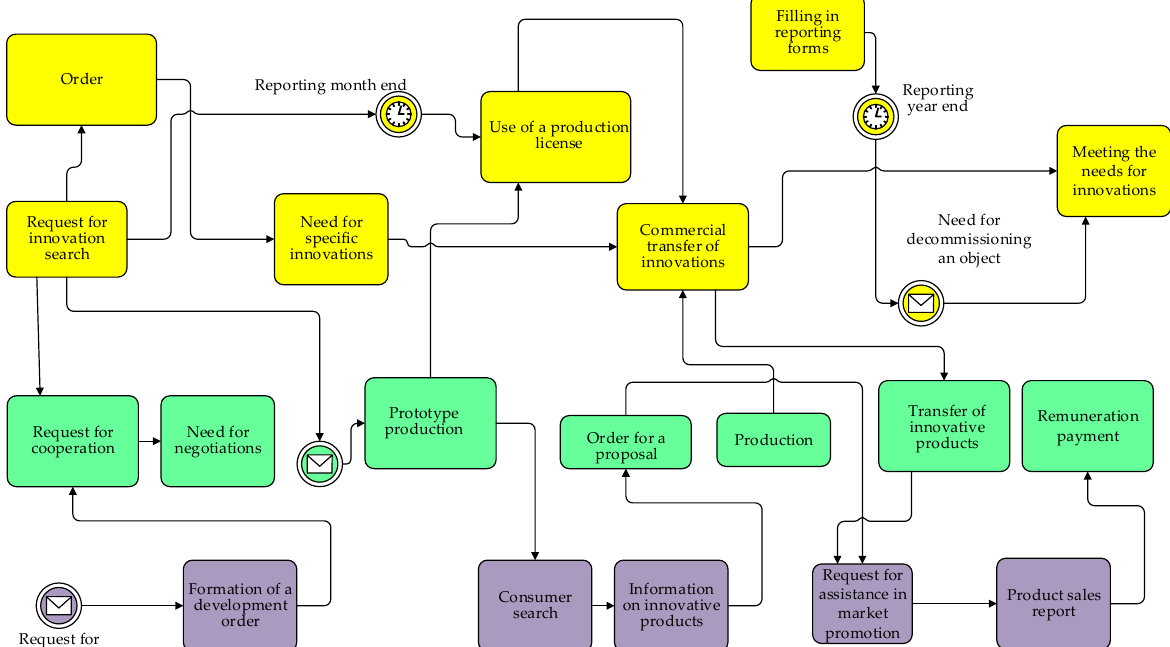
Figure 1. Structural and functional model of the search for cooperation between subjects in the process of promotion of innovative products on the market in BPMN notation (author’s research). model trigger—request for information. model trigger—event timer. manufacturing company. consumer company. transfer agents.